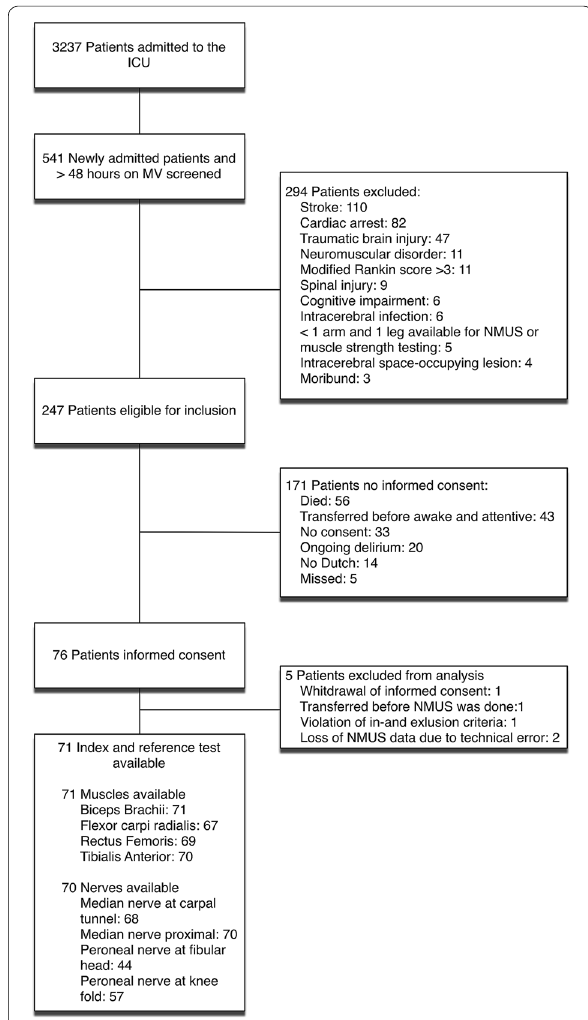
Fig. 1 Flowchart of patient screening and inclusion. ICU intensive care unit, MV invasive mechanical ventilation, NMUS neuromuscular